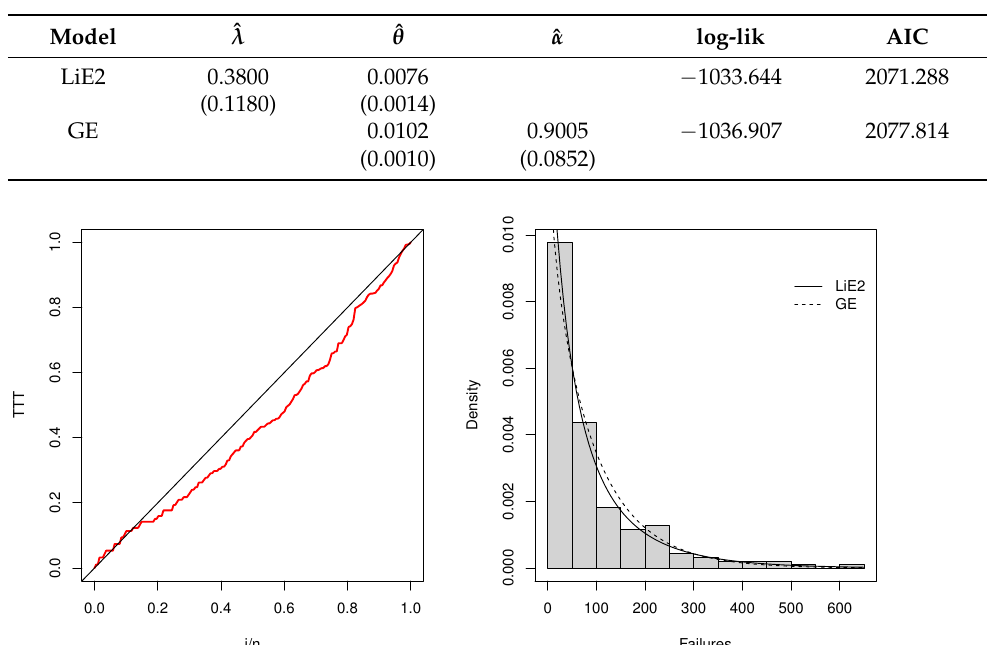
Table 6. Maximum-likelihood estimates with standard errors in parentheses, log-likelihood and AIC values for failure data.